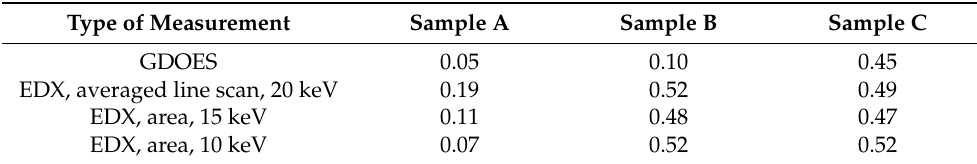
Table 4. [Ga]/([In] + [Ga]) ratios close to the front of the absorber calculated from different types of measurement.